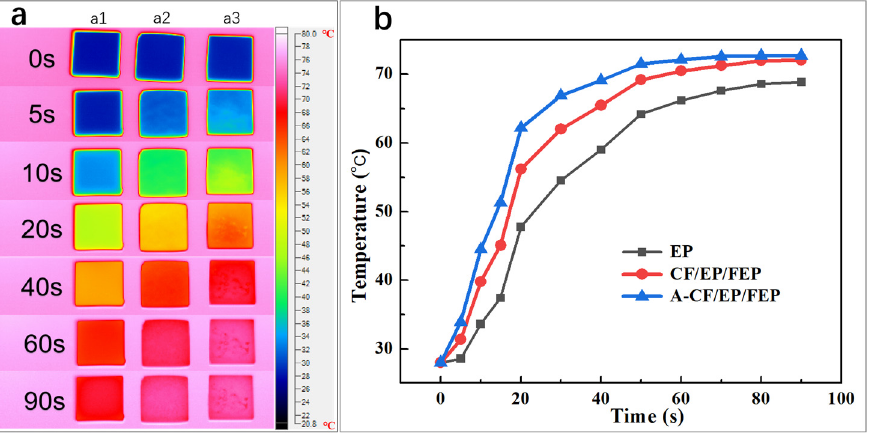
Figure 8. Infrared thermal images ( a ) and surface temperature variation with time ( b ) elapse of EP (a1), CF/EP/FEP (a2), and A-CF/EP/FEP (a3) composites during heating processes.